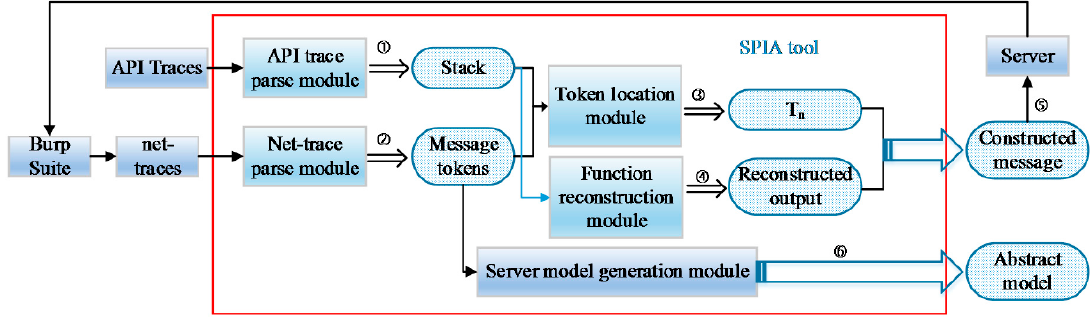
Figure 21. Analysis process with SPIA and Burp suite.